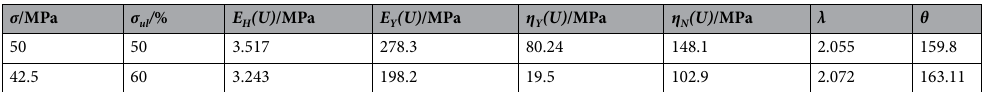
Table 7. Identification parameters of pre-peak unloading damage model under yield stress